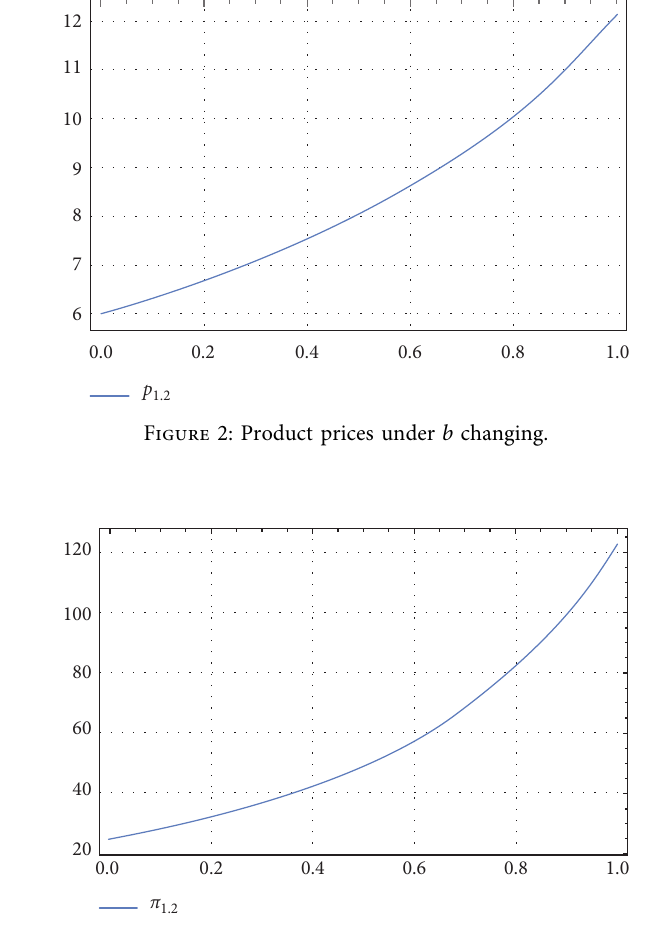
Figure 3: Corporate profits under b